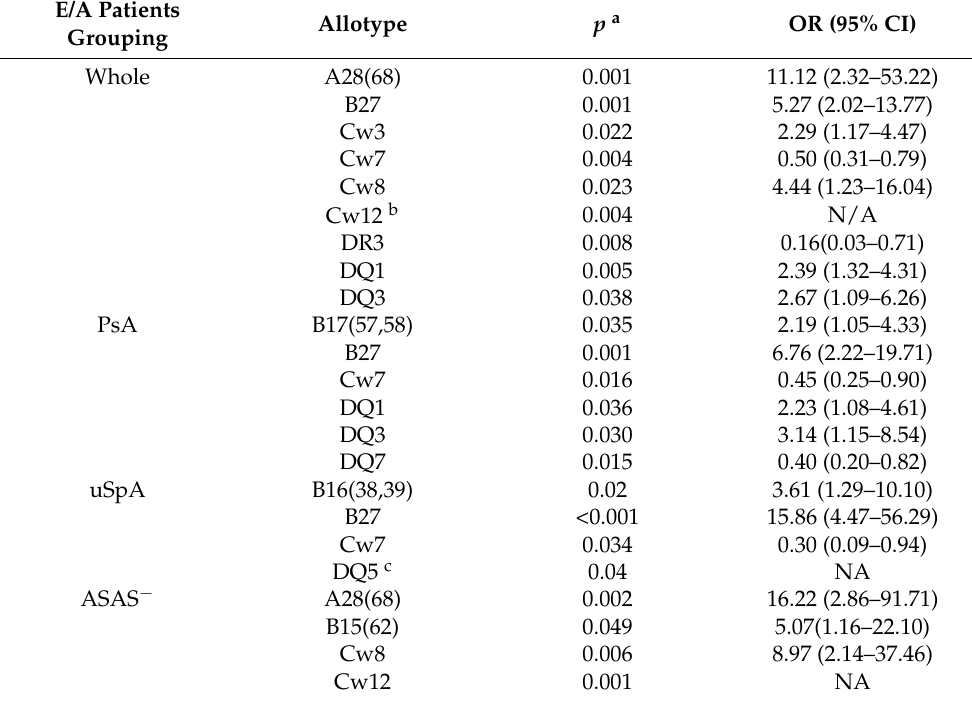
Table 4. Fisher’s exact test to define HLA allotypes showing a statistically higher (odds ratio; OR > 1) or lower (OR < 1) prevalence in peripheral seronegative enthesitis/arthritis (E/A) patients than in healthy donors